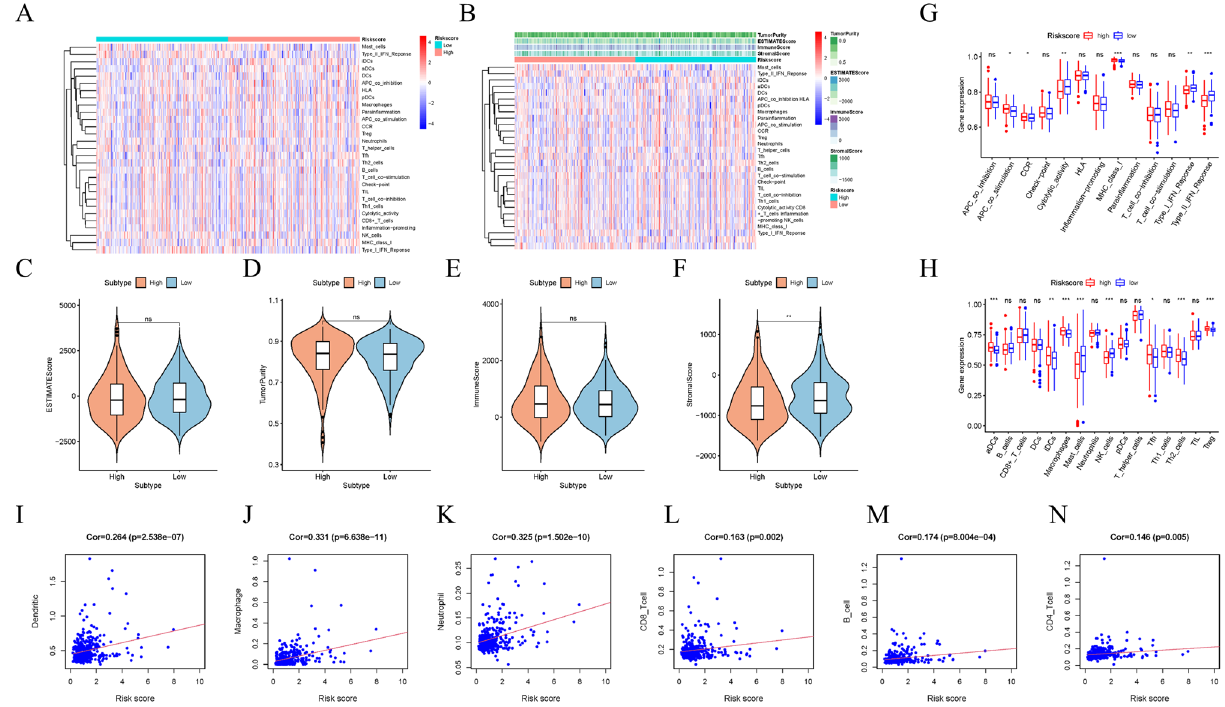
Figure 5. Risk score is closely related to tumor immune environment characteristics and immune infiltration in HCC. ( A , B ) Heat map (using “pheatmap” R package, https:// cran.r- proje ct. org/ bin/ windo ws/ base/ old/4. 1.3/) distribution of risk score and various immune scores. ( C – F ) Comparison of estimate score, stromal score, immune score, and tumor purity between high-risk groups and low-risk groups. ( G ) The relationship between immune function and risk score in TCGA cohort. ( H ) The relationship between immune cell infiltration and risk score in the TCGA cohort. ( I – N ) Association between this signature and B cells, CD4 + T cells, CD8 + T cells, dendritic cells, macrophages cells and neutrophil